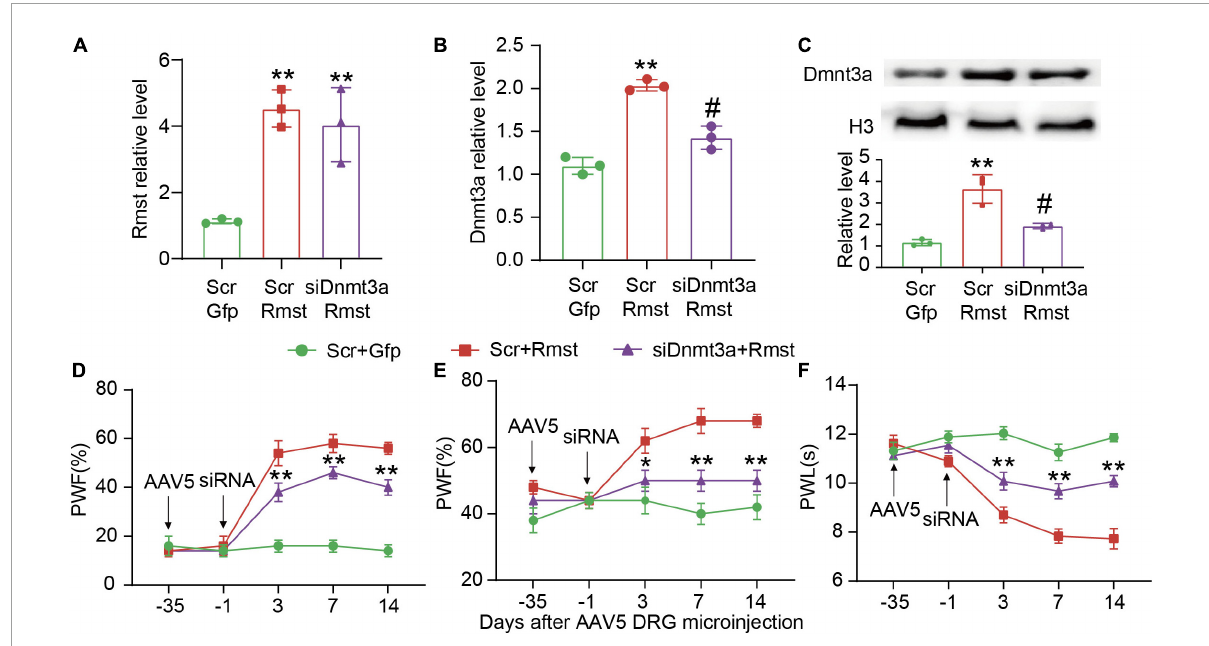
FIGURE6 Blocking DNA methyltransferase 3 alpha (Dnmt3a) expression mitigated the rhabdomyosarcoma 2-associated transcript ( Rmst ) triggered-mechanical allodynia and heat hyperalgesia. (A–C) Rmst mRNA (A) , Dnmt3a mRNA (B) , and Dnmt3a protein (C) in mice after microinjection with siDnmt3a (Scr as control) and AAV5-Rmst (AAV5-Gfp as control). ** P < 0.01 versus AAV5-Gfp + Scr group and # P < 0.05 versus AAV5-Rmst + Scr group. (D–F) The ipsilateral PWF to von Frey filament (D,E) and the PWL to thermal stimuli (F) after microinjection of siDnmt3a or Scr in mice pre-received with AAV5-Rmst or AAV5-Gfp. ** P < 0.01 versus AAV5-Rmst + Scr group.